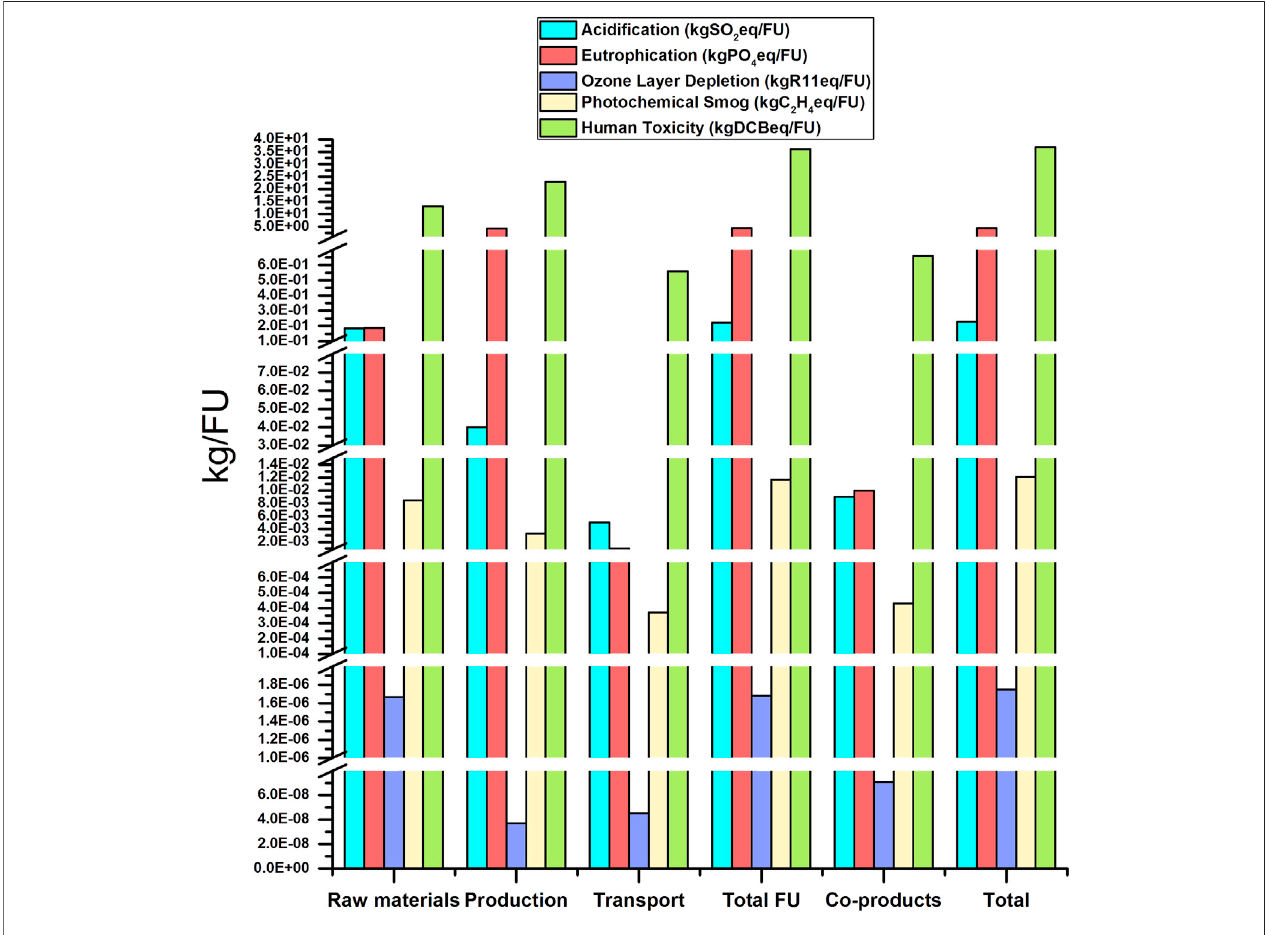
FIGURE 4 | Emissions on each impact category.